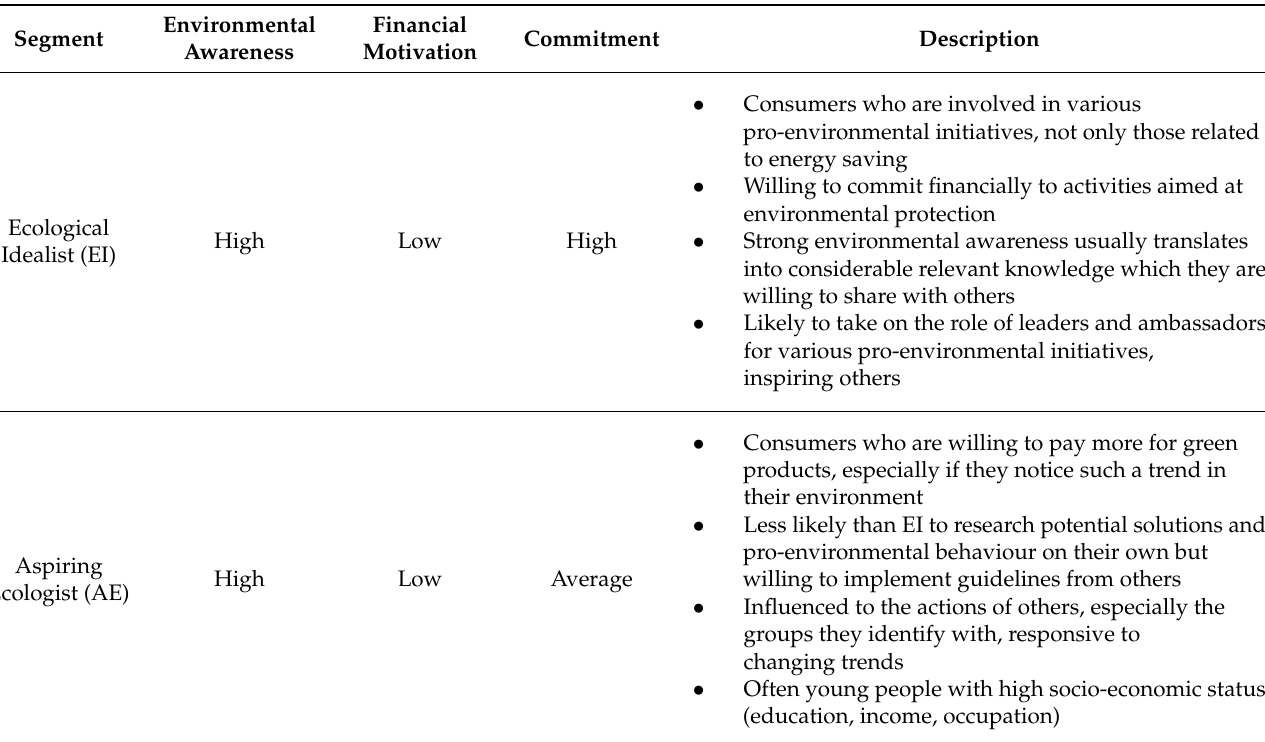
Table 3. Description of the